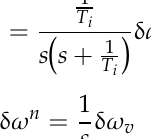
5 of 14 Figure 3. Block diagram of the self-alignment loop. Control angular rates ( (cid:2033) (cid:3015)(cid:3030) , (cid:2033) (cid:3006)(cid:3030) ) are calculated by